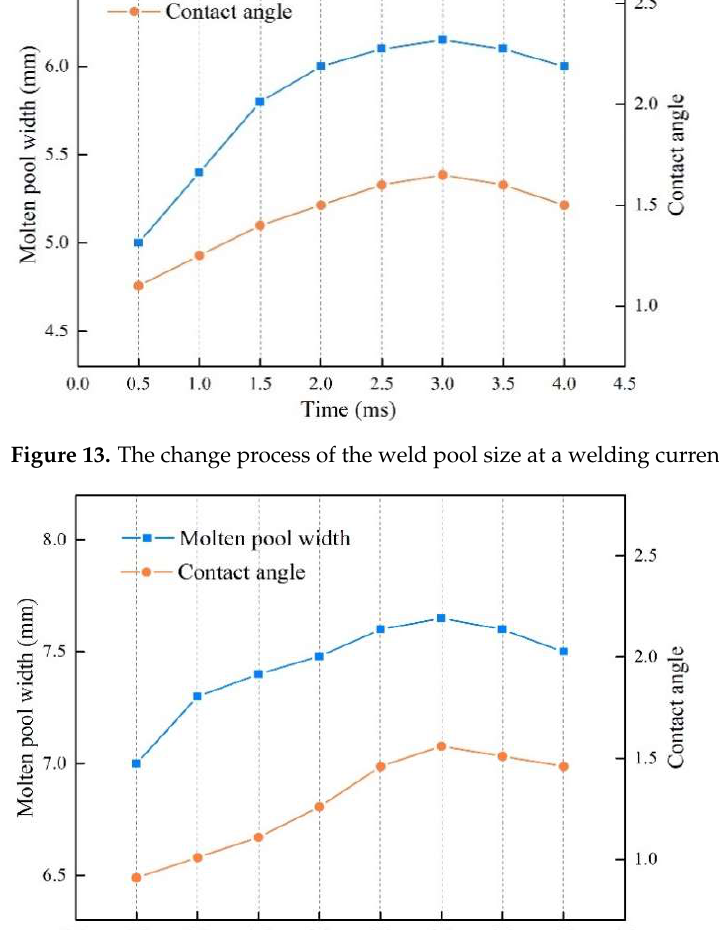
Figure 14. The change process of the weld pool size at a welding current of 100 A.